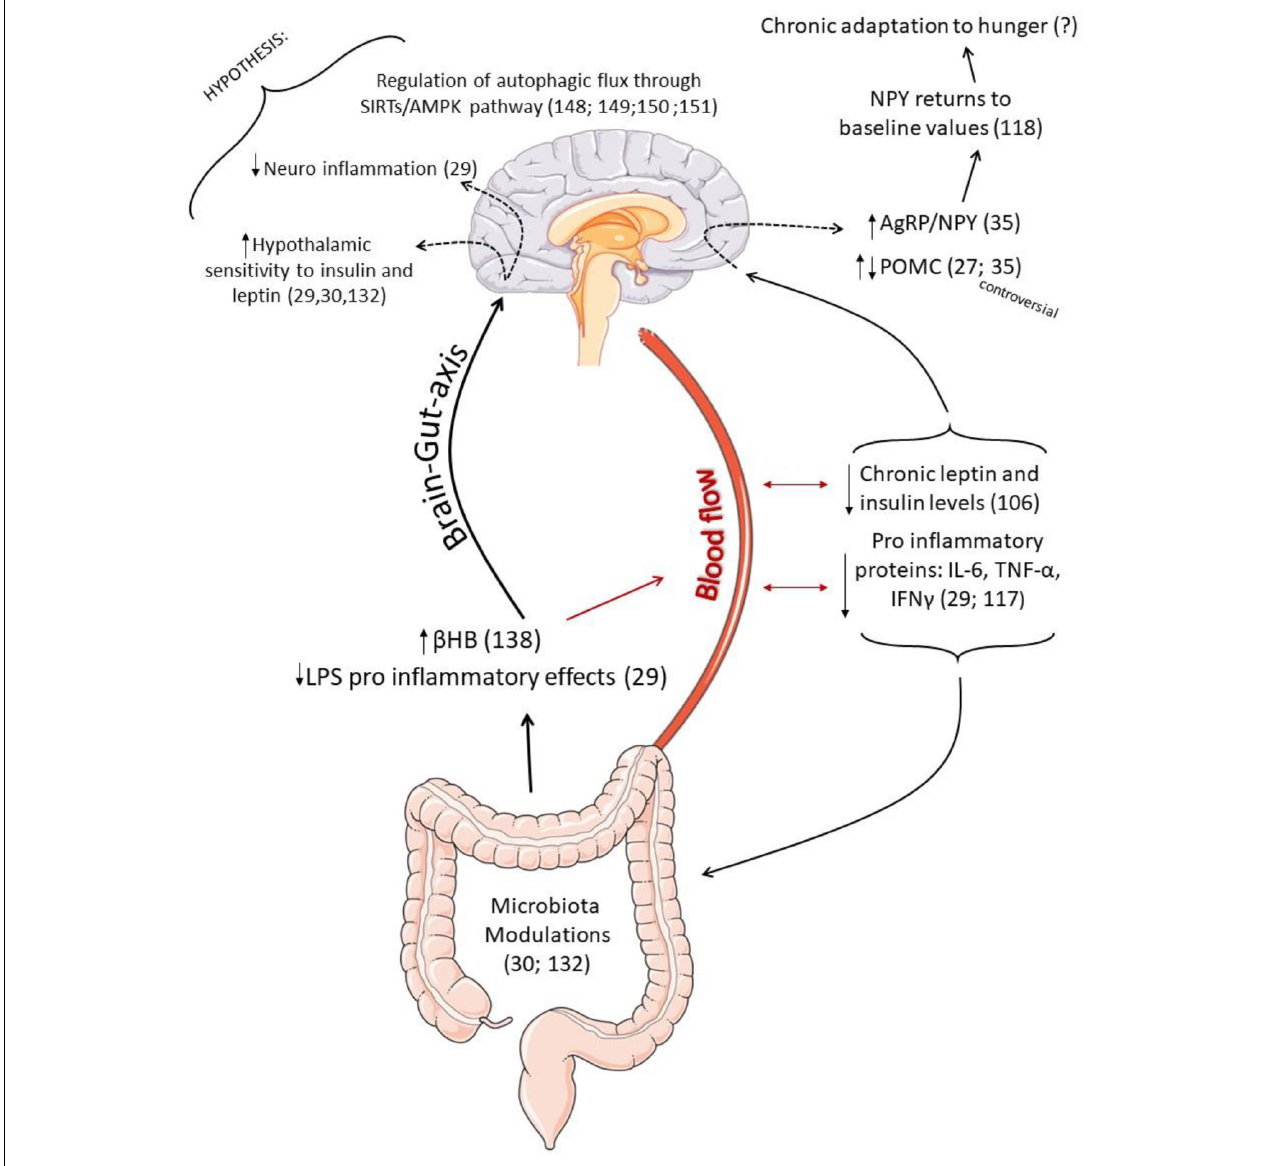
FIGURE 3 | Schematic representation of the possible effects of intermittent fasting (IF) as an adjuvant treatment to partially rescue hypothalamic responses in obesity. Once IF prevents the pro-inflammatory effects in the hippocampus caused by LPS (29), and it is also able to increase the production of β -Hydroxybutyrate ( β HB) (136), correlated to inflammatory control (134) and insulin sensitivity, it is possible to hypothesize that modulations in the microbiota may be helpful to reduce hypothalamic inflammation and increase hormonal sensitivity. Low serum leptin and insulin values during fasting contribute to an increase in the expression of AgRP and NPY. However, interestingly, the NPY mRNA expression returned to baseline values as a chronic response to IF, which may be is an adaptation to hunger. Furthermore, some studies found an increase in the expression of POMC neuropeptide, which is controversial. Such neuronal sensitivity to the IF protocol is perhaps also associated with better regulation of hypothalamic autophagic response since IF can activate the autophagic pathway in other tissues (146), and autophagic flux is an essential mediator of neuropeptide responses.